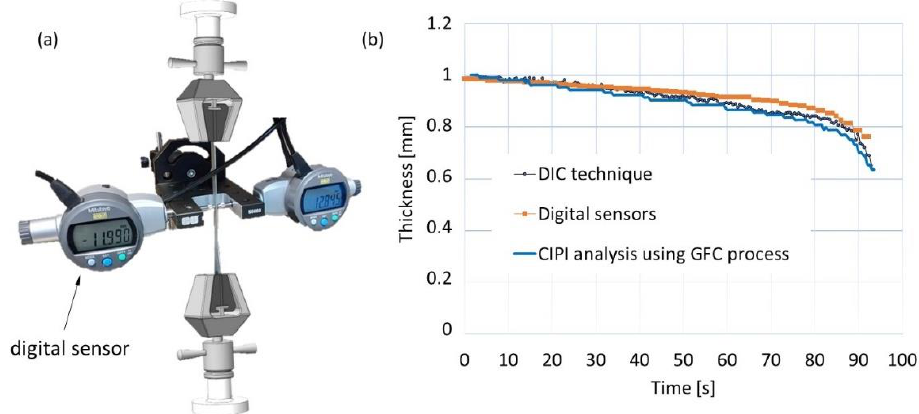
Figure 15. Thickness measurement: ( a ) designed thickness measurement gauge, ( b ) comparison of the thickness measurement (digital gauge) and thickness calculation using DIC technique and CIPI analysis.